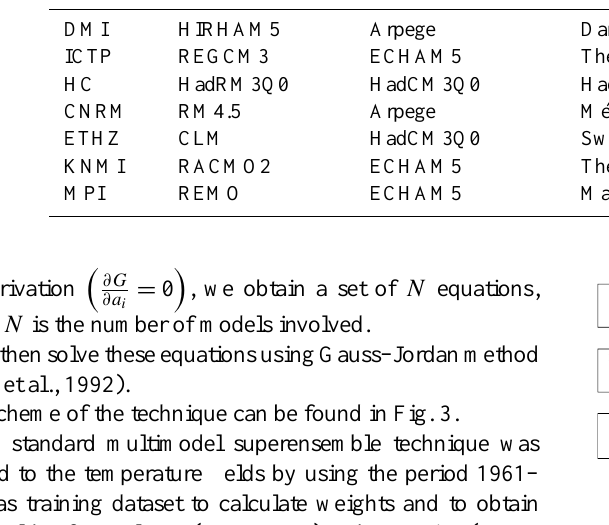
Interpolation (on observation gridpoints)